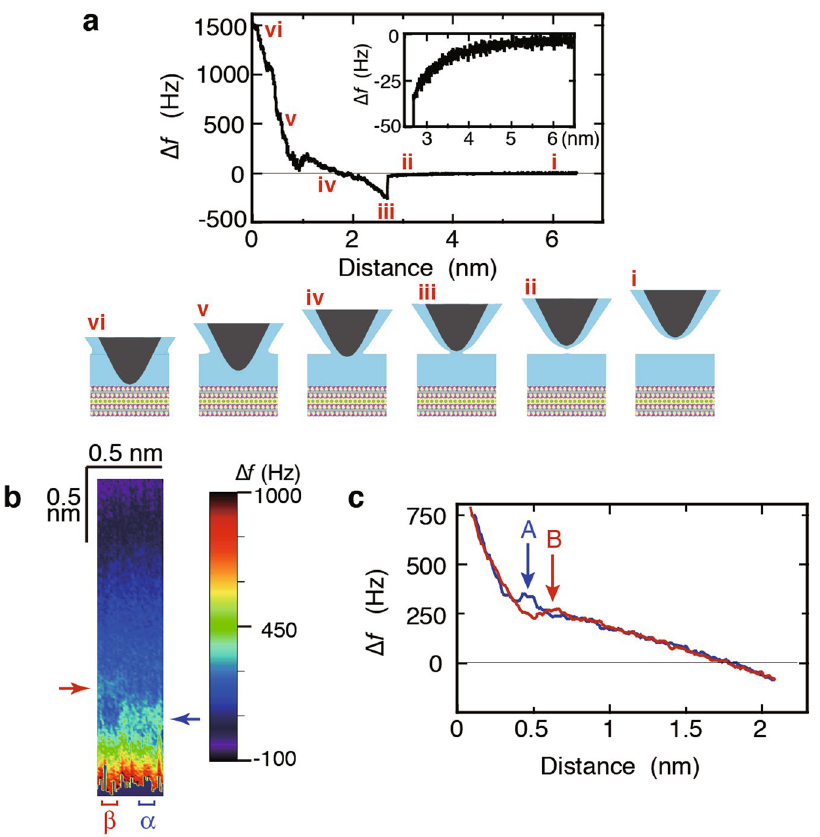
Figure 2. Characteristic changes on ∆ f with respect to tip–sample distance ( z ). ( a ) Typical ∆ f –distance ( z ) curve measured for the tip approaching the muscovite surface from above the water film. The schematics of change of the tip distance with respect to the sample are shown from i to vi, corresponding to the tip approach from a far distance to a proximity to the surface. The closest distance was referred to as z = 0, shown in vi. This tip distance is regarded as the point of approximate contact between the tip apex and the muscovite surface, at which the cantilever oscillation became unstable and the oscillation amplitude small because of the repulsive forces between the tip and the sample. The inset shows the magnified curve before the tip touched the surface of water film. ( b ) Cutout from a two-dimensional ∆ f map. The bottom shows the muscovite surface. The tip repeatedly approached and returned in a distance range, e.g., between iv and vi as seen in a , while shifting its lateral position step-wise with a ~0.44 nm width of x -scan, composed of 33 lines, and a ~2 nm-height of z - scan. The tip approach was stopped and the tip retracted when ∆ f reached 750 Hz. The region with a ∆ f peak (indicated by the blue arrow) near the surface is denoted by α , and the region with a ∆ f peak (indicated by the red arrow), about 0.2 nm farther from the surface, is denoted by β . ( c ) ∆ f – z curves, which are extracted from b in region α and region β , respectively, labeled by curve A (blue) and curve B (red). Each curve is composed of 8 lines on average. The peak in curve A was found at z ≈ 0.4 nm (denoted by arrow A), and the peak in curve B at z ≈ 0.6 nm (denoted by arrow B). The resonant frequency, spring constant, and oscillation amplitude of the cantilever were 342.5 kHz, 48 N/m, and 0.46 nm,